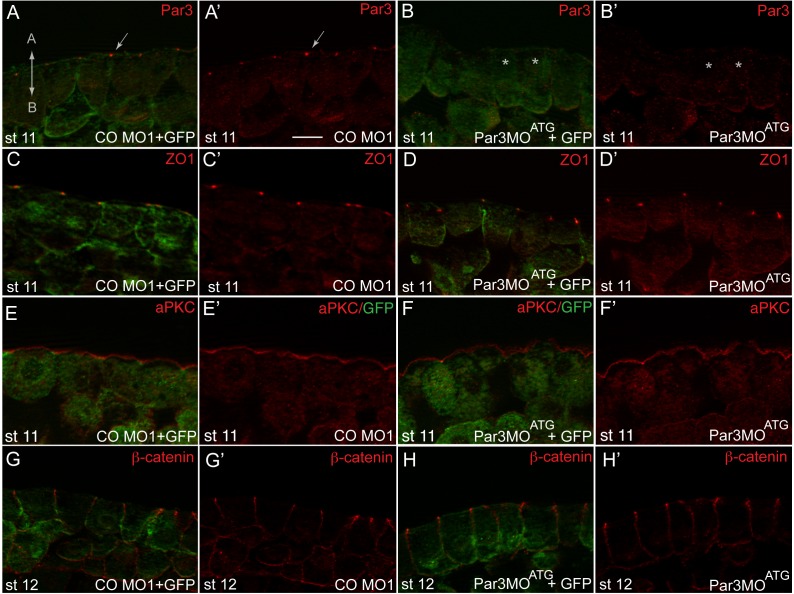
Par3 depletion does not affect the localization of aPKC, b-catenin and ZO1 in gastrula ectoderm.Early embryos were injected with control morpholino (CO MO1) or Par3MOATG (20 ng each) and GFP RNA (100 pg) as a lineage tracer, cultured until stage 11 or stage 12, sectioned and stained for junctional, polarity markers and GFP as indicated. CO MO1 has no effect on (A) Par3 (arrow), (C) ZO1, (E) aPKC and (G) b-catenin. (B, D, F, H) Par3MOATG reduced levels of (B) Par3 (asterisks), but not (D) ZO1, (F) aPKC or (H) b-catenin. (A–H) merged images showing co-staining with GFP. Scale bar, 20 µm. Apicobasal (A–B) axis is indicated. Images are representative of 3 independent experiments, each containing 15–20 embryos per group.